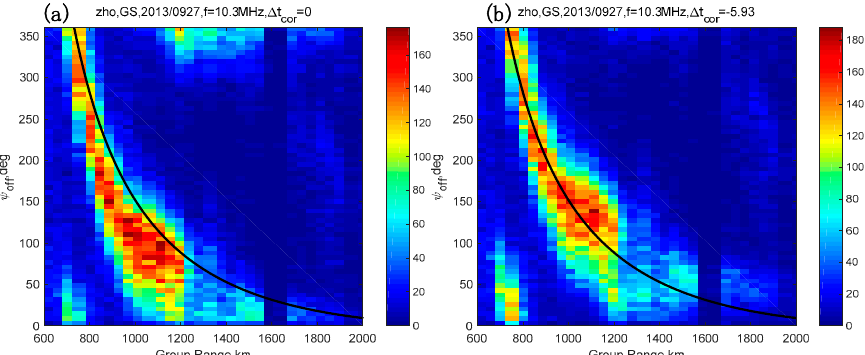
distribution of the phase deviation changes with the group ranges with ∆ t cor ≈ − 5.93 ns. The center of the actual distribution is consistent with the theoretical curve.